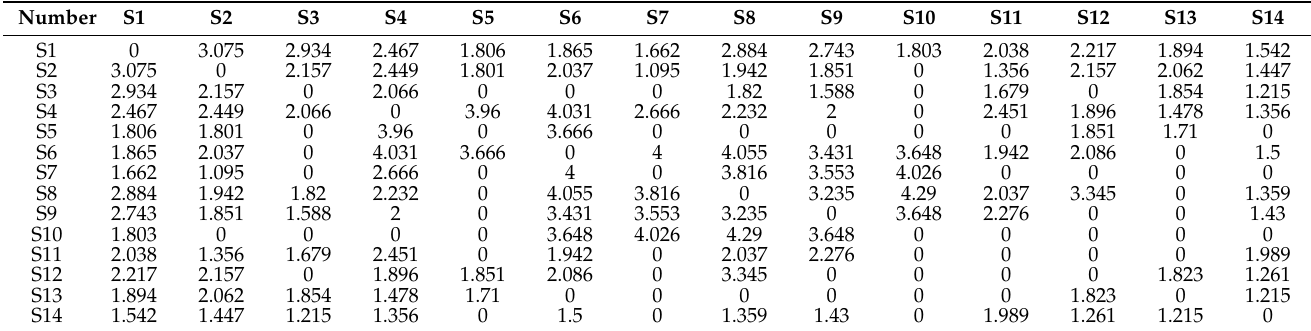
Table 4. Matrix of governance relationships among